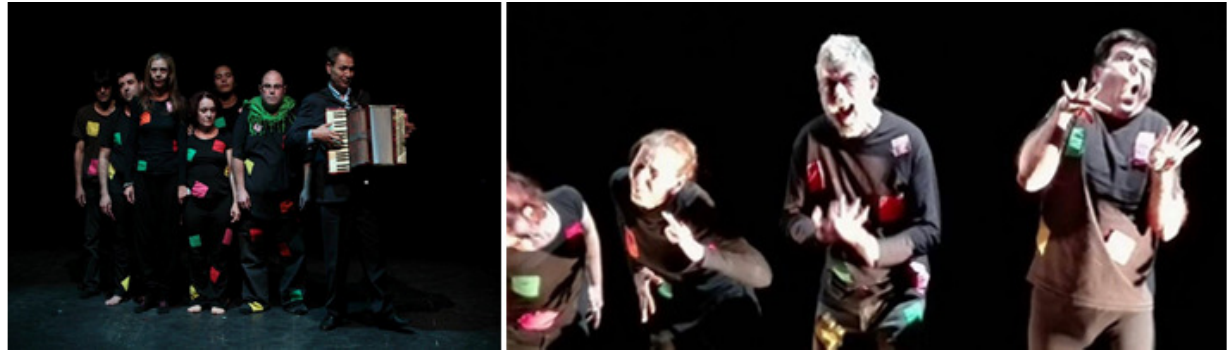
Figure 5. Two scenes from Breves Relatos de Vergüenza y Olvido . relating to aesthetics, methodology, production, etc.